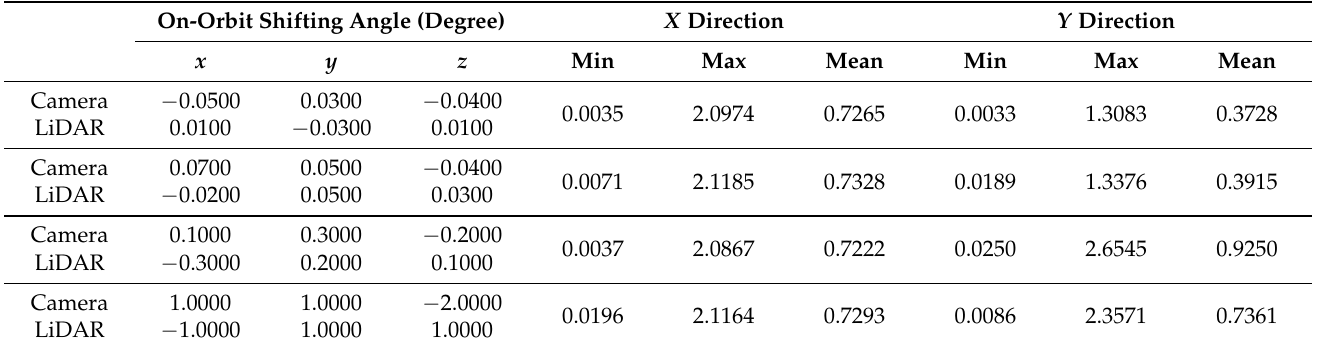
Table 2. On-orbit shifting angle of sensors and calibration results.